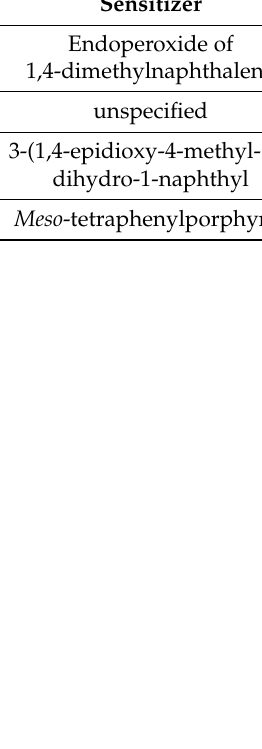
Table 1. Second-order singlet oxygen quenching rate constant of macular xanthophylls in organic solvent. Sensitizer Organic Solvent Zeaxanthin Lutein